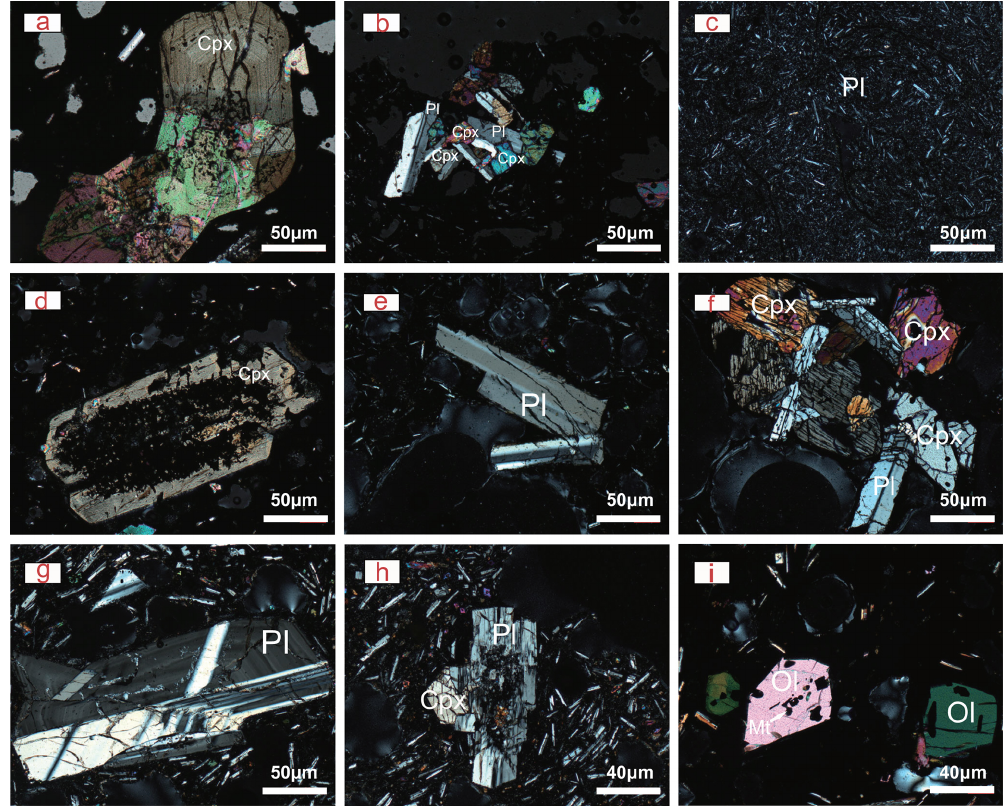
Figure 3. Representative photomicrographs of volcanic rocks in the WVF under cross-polarized light. (a) Zoned clinopyroxene-dominated glomerocryst from NLDL. (b) Glomerocryst of plagioclase and clinopyroxene from NLDL. (c) Plagioclase-dominated matrix from NLDL. (d) Large sieve-textured clinopyroxene phenocryst from ZLDL. (e) Euhedral, homogeneous plagioclase phenocryst from HNB. (f) Glom- erocrysts containing clinopyroxene and plagioclase, from HNB. (g) Oscillatory zoned plagioclase phenocryst from HSS. (h) Subhedral plagioclase phenocryst with strongly sieve-textured core from HSS. (i) Euhedral olivine phenocrysts with oxide mineral inclusions from HS. Abbreviations: Ol, olivine; Cpx, clinopyroxene; Pl, plagioclase; Mt, magnetite. Table 2. Summary of the mineral assemblage of the WVF. Volcano